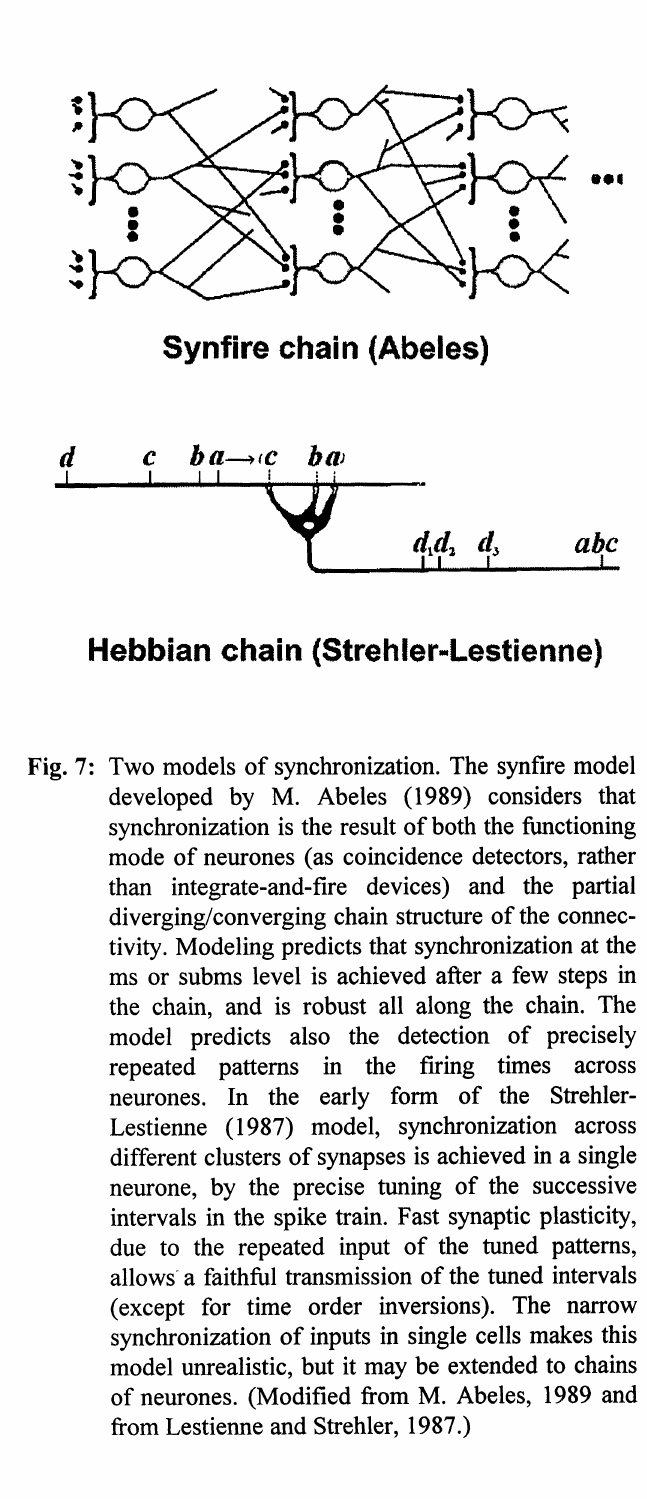
Fig. 7: Two models of synchronization. The synfire model developed by M. Abeles (1989) considers that synchronization is the result of both the functioning mode of neurones (as coincidence detectors, rather than integrate-and-fire devices) and the partial diverging/converging chain structure of the connec- tivity. Modeling predicts that synchronization at the ms or subms level is achieved after a few steps in the chain, and is robust all along the chain. The model predicts also the detection of precisely repeated pattems in the firing times across neurones. In the early form of the Strehler- Lestienne (1987) model, synchronization across different clusters of synapses is achieved in a single neurone, by the precise tuning of the successive intervals in the spike train. Fast synaptic plasticity, due to the repeated input of the tuned pattems, allows a faithful transmission of the tuned intervals (except for time order inversions). The narrow synchronization of inputs in single cells makes this model unrealistic, but it may be extended to chains of neurones. (Modified from M. Abeles, 1989 and from Lestienne and Strehler,